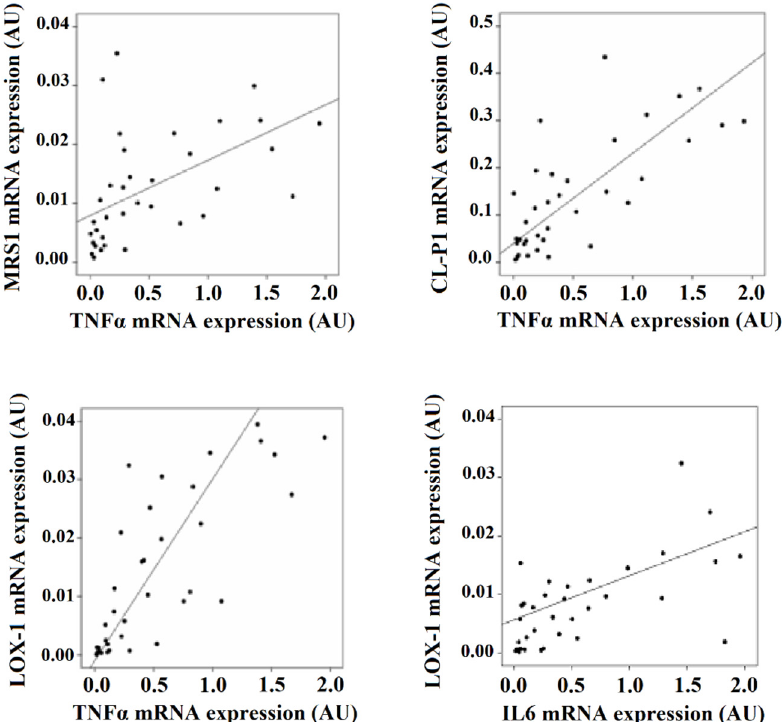
Figure 5. Significant correlations found in visceral mature adipocytes between the mRNA expres- sion of scavenger receptors with HIF-1 α and IL6.